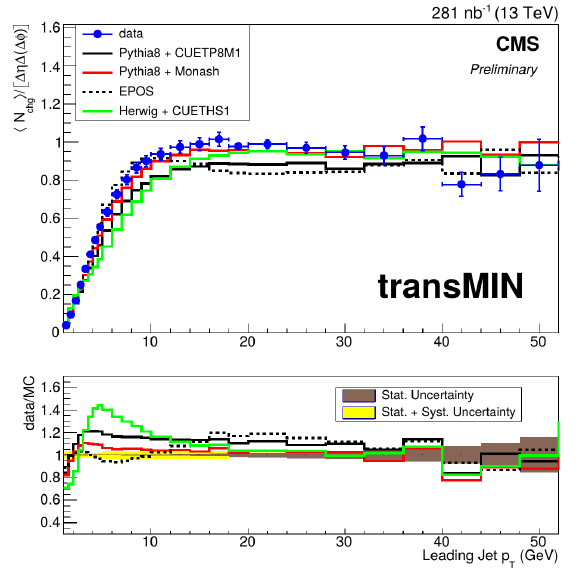
Figure 10. Output of a boosted decision tree for same-sign WW events in proton-proton collisions at 8TeV. All relevant signal contributions are outlined. See Ref.